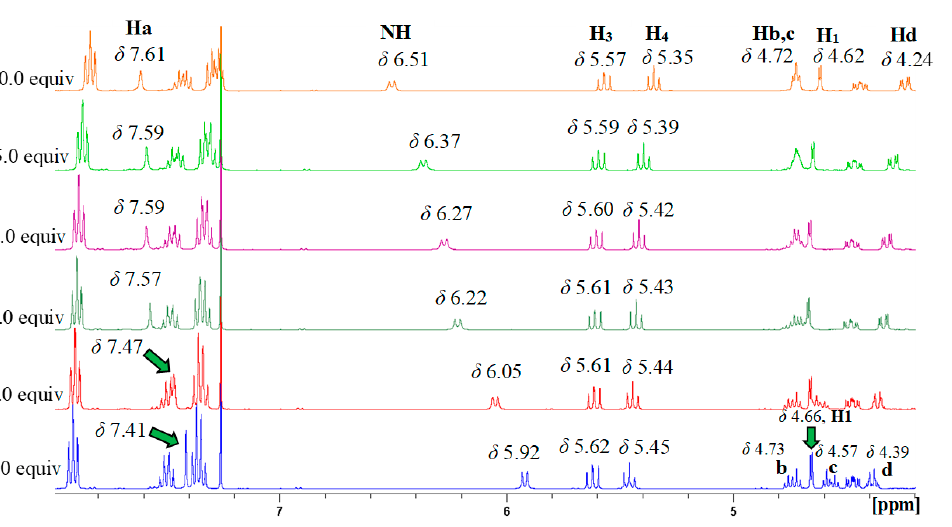
Figure 2. Structures of several macrocycles and the protons assigned.